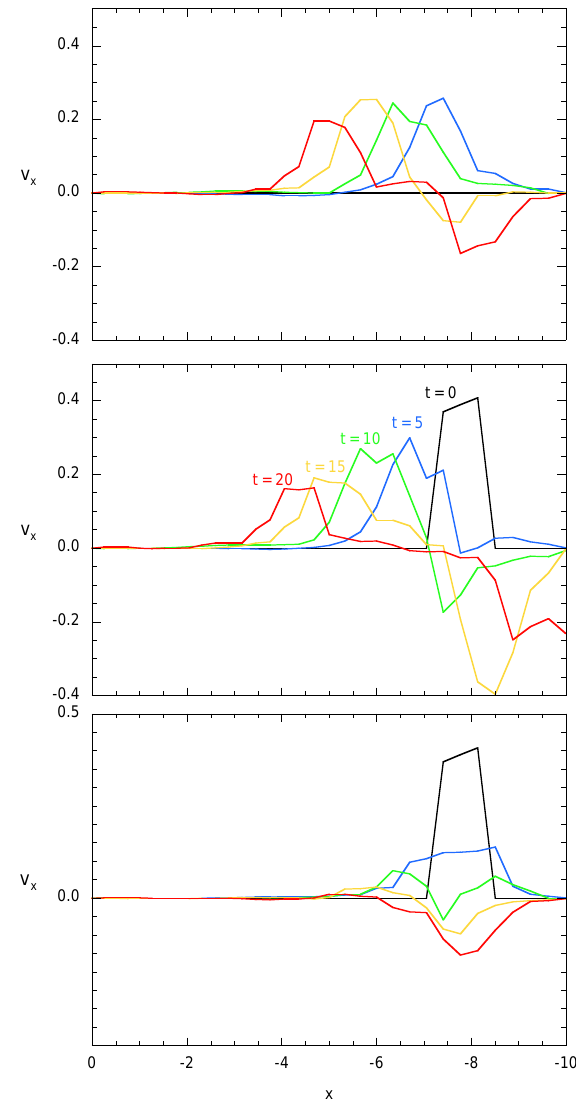
Fig. 14. Velocity profiles v x (x) at various times for the three cases of Fig. 13, (a) pressure reduction but no initial velocity, (b) pressure reduction and initial velocity, (c) no pressure reduction but finite initial